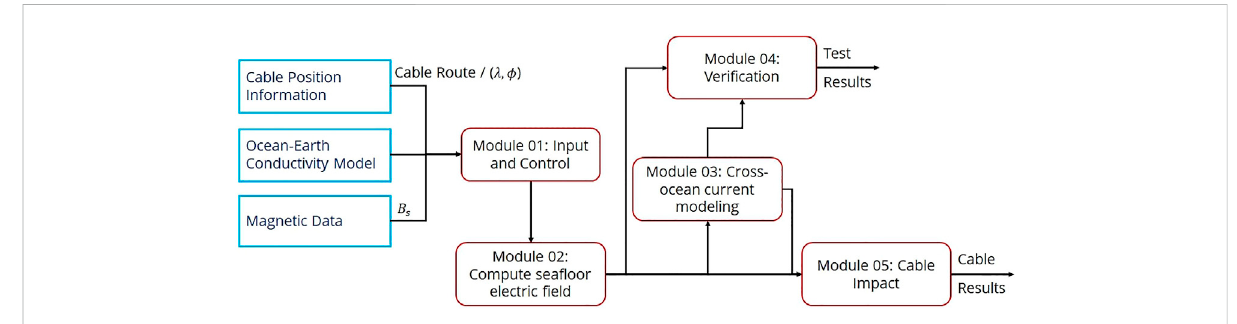
FIGURE 1 Control fl ow diagram of operations done by computational model. The boxes in red and blue de fi ne operational and input modules, respectively. Solid lines represents data fl ow interconnections between different modules.